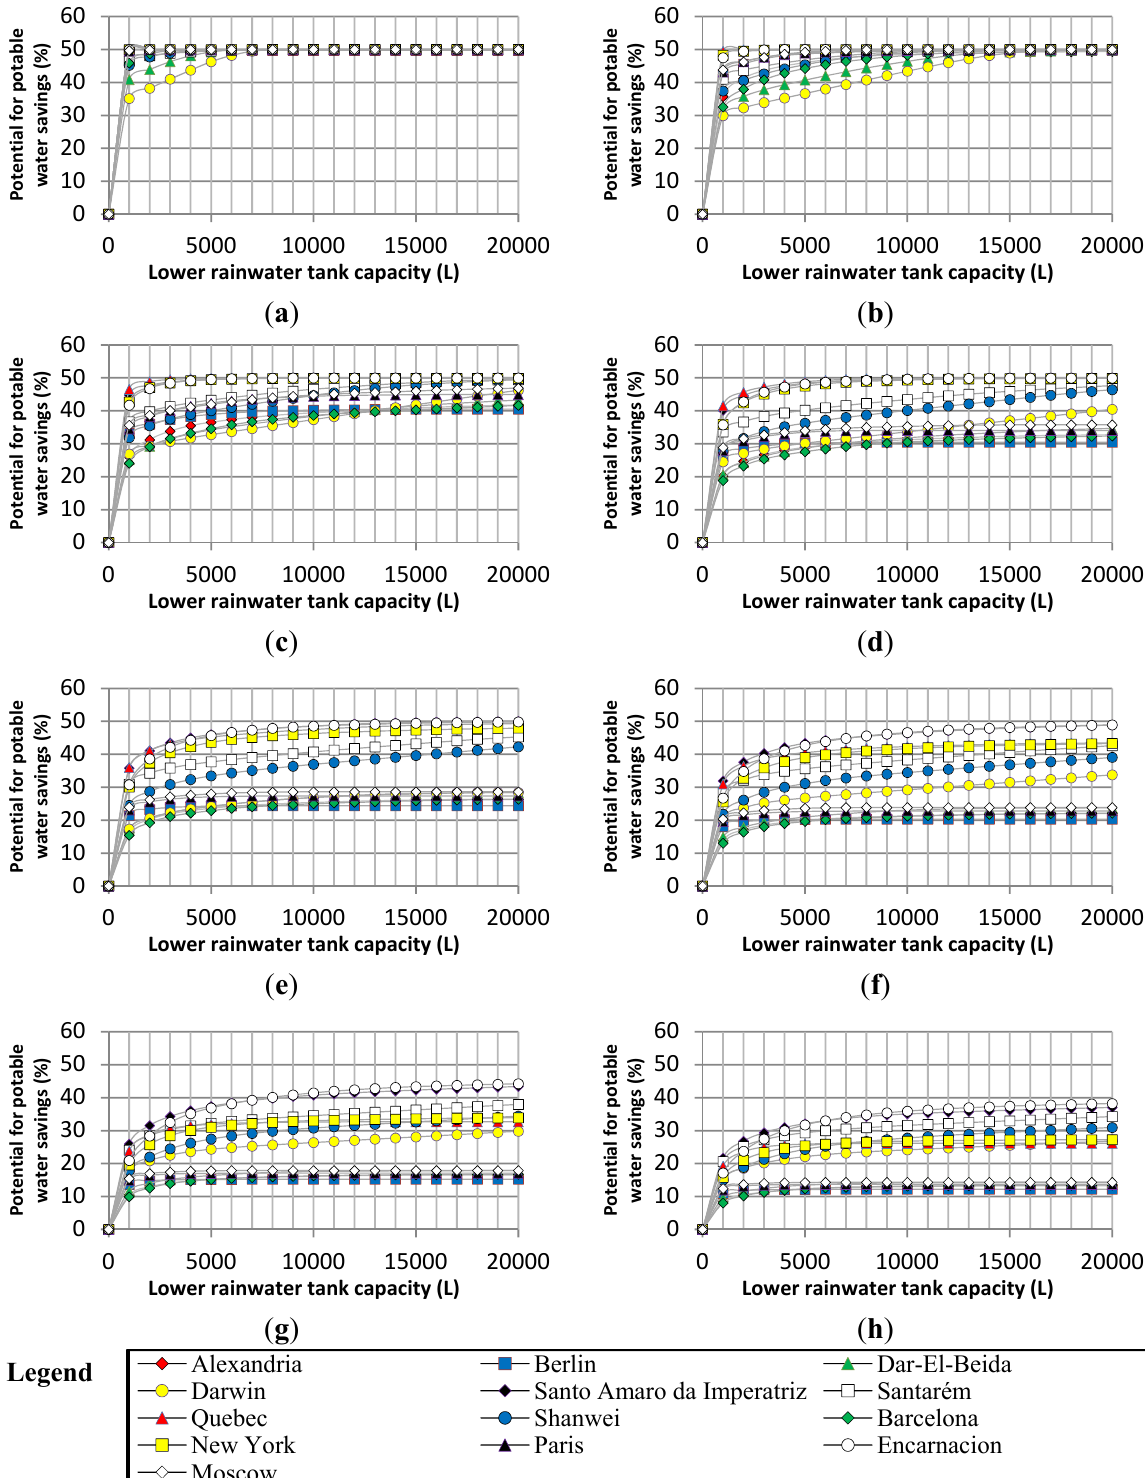
Figure 5. Potential for potable water savings for each city as a function of rainwater demand and catchment surface area of 100 m 2 . ( a ) Rainwater demand of 50 L per house per day; ( b ) Rainwater demand of 100 L per house per day; ( c ) Rainwater demand of 150 L per house per day; ( d ) Rainwater demand of 200 L per house per day; ( e ) Rainwater demand of 250 L per house per day; ( f ) Rainwater demand of 300 L per house per day; ( g ) Rainwater demand of 400 L per house per day; ( h ) Rainwater demand of 500 L per house per